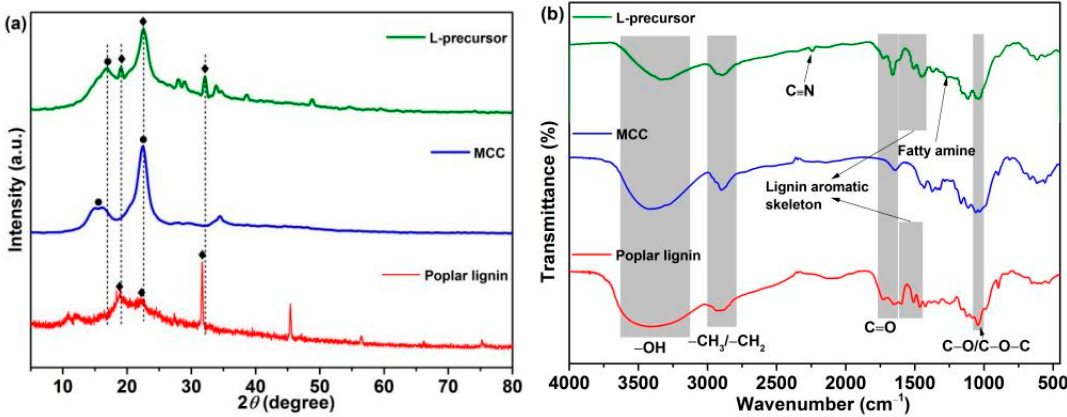
Figure 2. ( a ) XRD and ( b ) FTIR spectra of the samples.